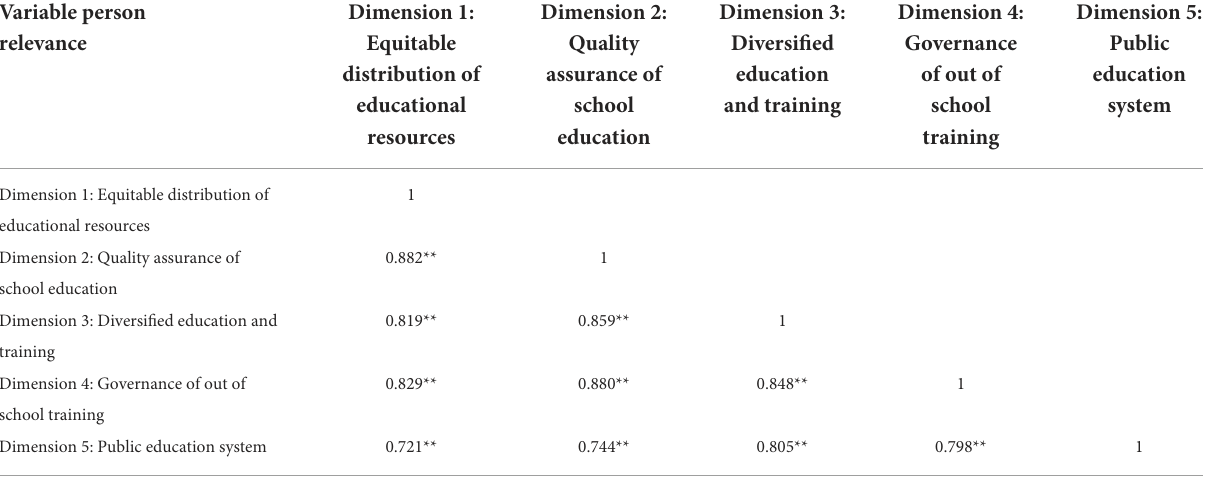
TABLE 14 Correlation analysis between various dimensional